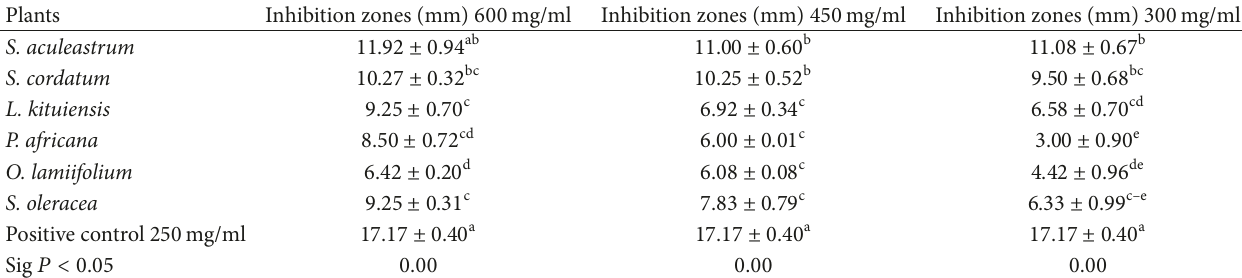
Table 1: Effect of different plant extracts on growth of A. flavus strain UONV003 at different concentrations.